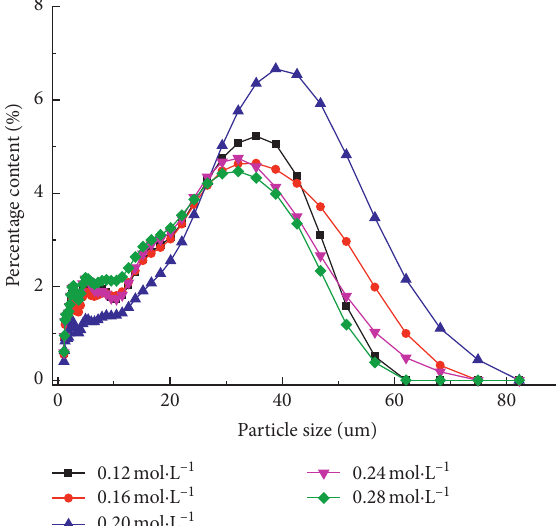
· L − 1 (NH 4 ) 2 SO 4 solution.